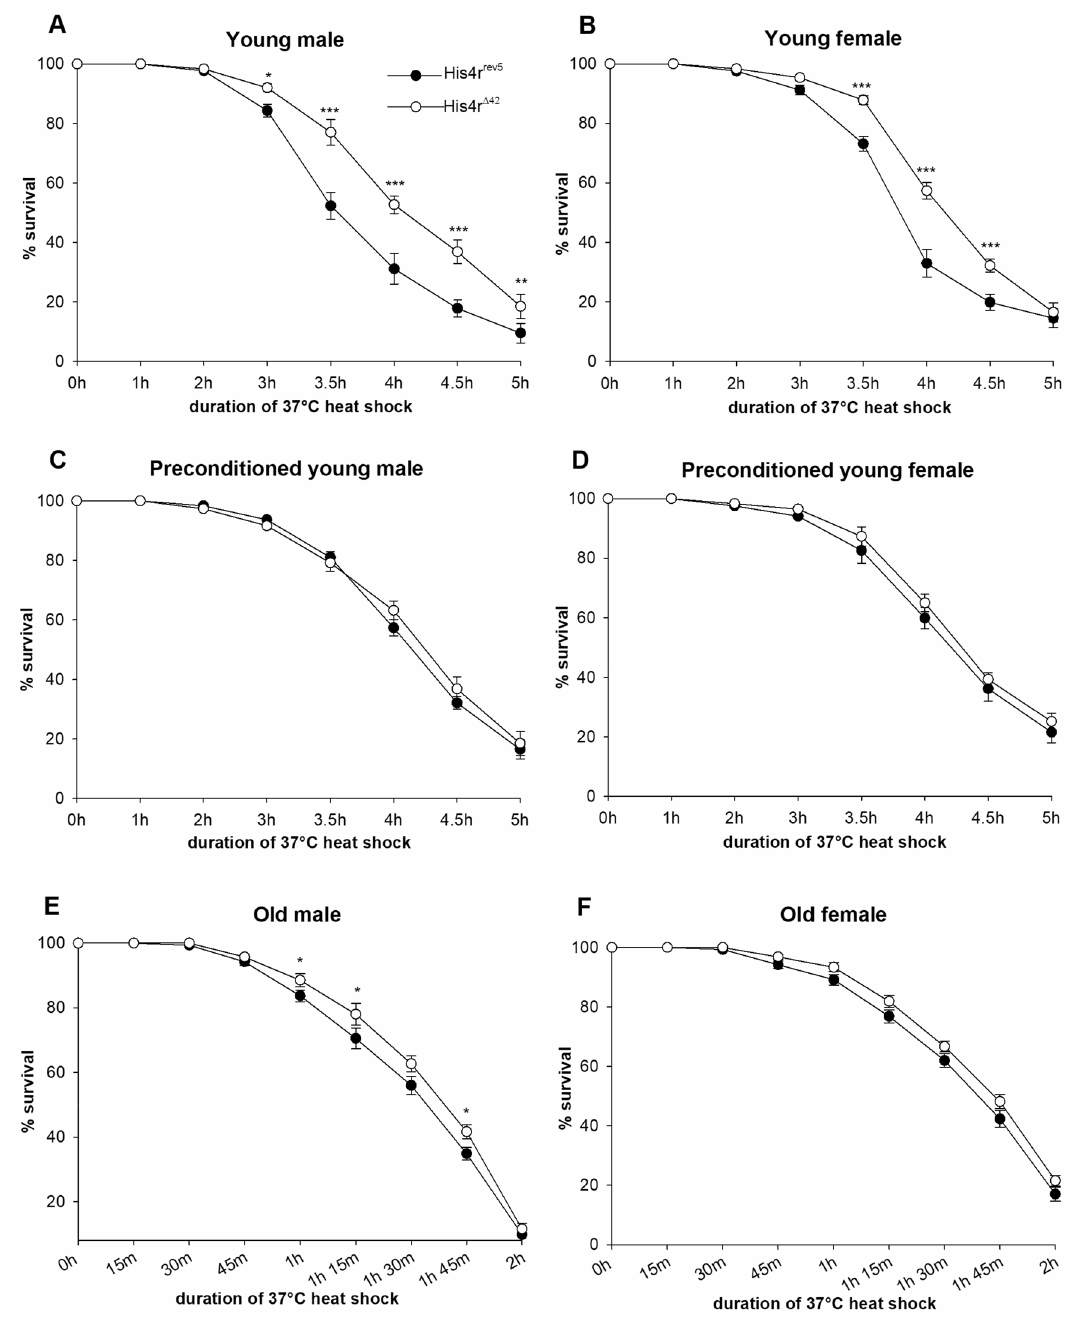
Figure 5. Loss of His4r increases heat-stress tolerance. Both 3–5 days old His4r Δ42 males ( A ) and females ( B ) showed increased heat-stress tolerance compared to revertant controls. The survival rate of His4r Δ42 males was significantly higher than controls after 3.5–5 h of heat-stress at 37 °C, while the survival rate of His4r Δ42 females was higher than controls after 3.5–4.5 h of heat-stress. After preconditioning for 30 min at 34 °C on two preceding days there was no difference between the survival rates of 3–5 days old His4r Δ42 males ( C ) or females ( D ) and corresponding controls after heat-stress at 37 °C. 30 days old males ( E ) and females ( F ) showed reduced heat-stress tolerance compared to younger flies ( A , B ), and homozygous loss of His4r had only a minor effect on survival following heat shock (male: P = 0.009; female: P = 0.0114, log-rank test). The graph shows the average survival rate, error bars show standard error, n = 30 vials (20 flies/vial).*P < 0.05, **P < 10 −2 , ***P < 10 −3 , Mann– Whitney U